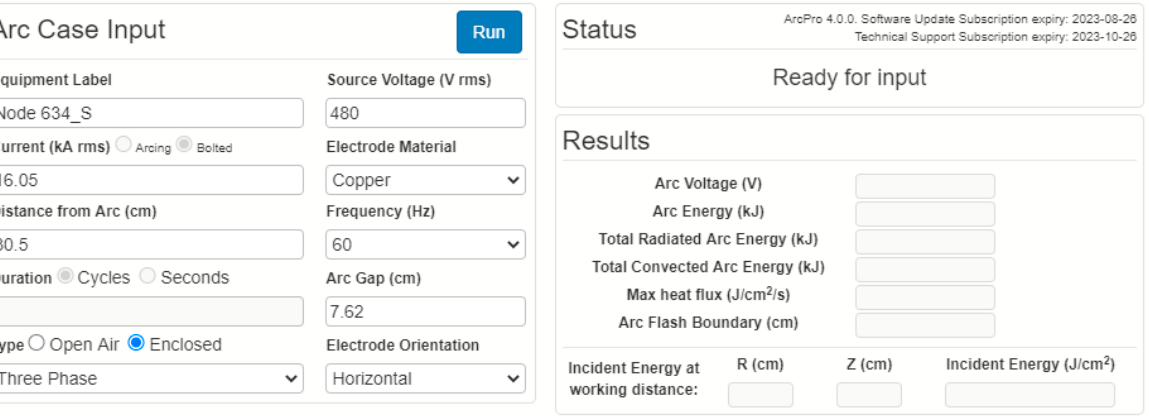
Figure 11. Data input screen for ArcPro simulation—Case study 4. Table 8. Relation of input data for ArcPro simulation—Case study 4.